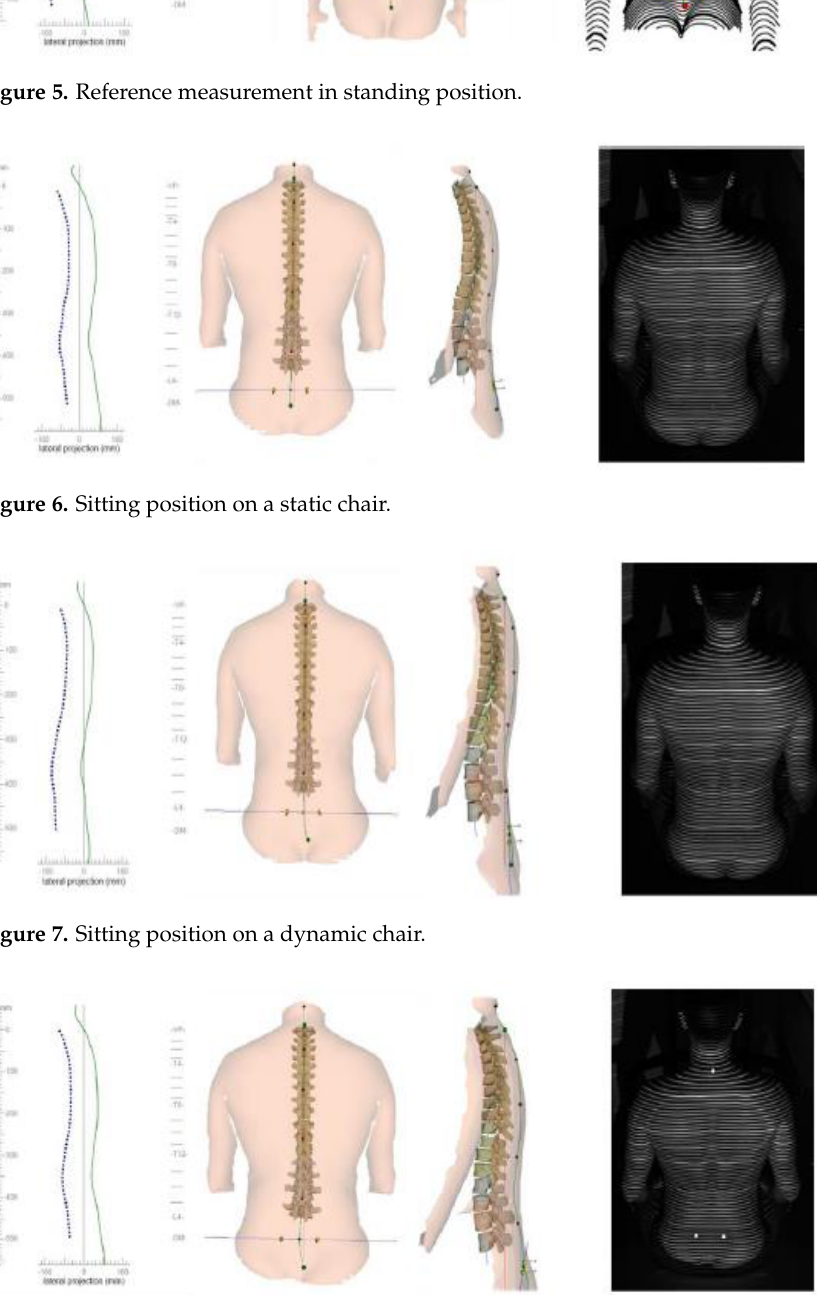
Figure 8. Sitting position on a physiotherapeutic ball.